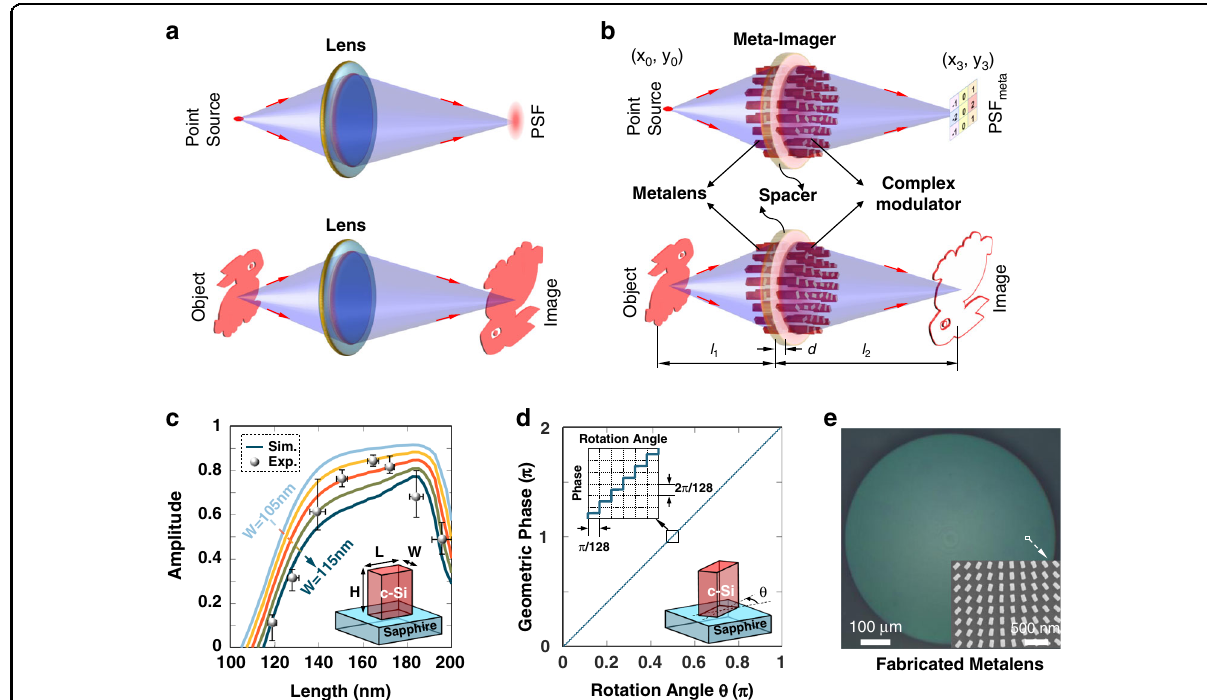
Fig. 1 Working principle of meta-imager for arbitrary convolution operation. a Sketch for the imaging process of a single imaging lens with an Airy-spot-like point spread function (PSF). b Mechanism of meta-imager composed of a metalens and complex-amplitude meta-modulator. The PSF meta of this meta-imager can be reshaped into an arbitrary pattern, which can be used as the kernel of the convolution operation. The spacer exists between the metalens and the meta-modulator. The position ( x 0 , y 0 ) and ( x 3 , y 3 ) stand for the coordinates of object and image spaces, respectively. c Simulated (curves) and experimental (dots) amplitude modulation by using geometric metasurfaces made of dielectric c-Si nanobricks with different lengths L , where the height H = 300 nm and the width W = 110 nm. Considering the fabrication error, we provide the simulated L - dependent amplitude pro fi les if the width W (from 105 nm to 115 nm) has deviated with a step size of ±2.5 nm. The simulation about the amplitude modulation is implemented in a fi nite-difference time-domain model with the periodic boundaries along x and y direction, and perfect-matching layers along z -direction. In our simulation, the periods ( p x and p y ) of metasurfaces are taken to be 250 nm, which is below the operating wavelength ( λ = 633 nm). The experimental amplitude (calculated as the square of polarization conversion ef fi ciency) and length L (directly measured from the SEM images) of the nanobricks are derived from fi ve individual samples, which exhibit similar behavior. The insert presents the con fi guration of a unit cell in geometric metasurfaces. d Phase modulation is determined by the rotation angle of nanobricks. One hundred twenty-eight-level phase modulation is employed to obtain a high-accuracy meta-modulator. The insert illustrates the orientation-rotated nanobricks with a rotating angle θ . e Optical and SEM (insert) images of our fabricated metalens, where the nanobriks have the dimension of W = 110 nm and L = 170